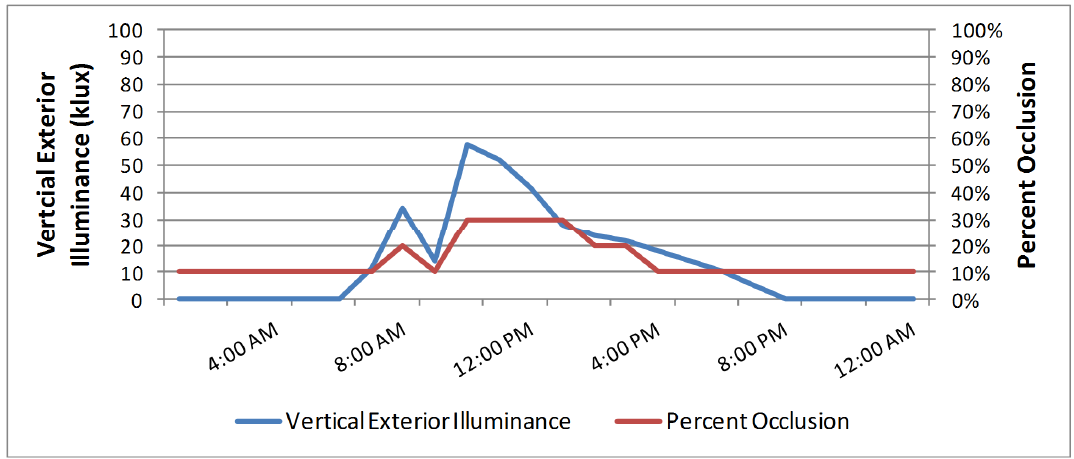
Figure 15. Control algorithm responses (Blindswitch B) on 22